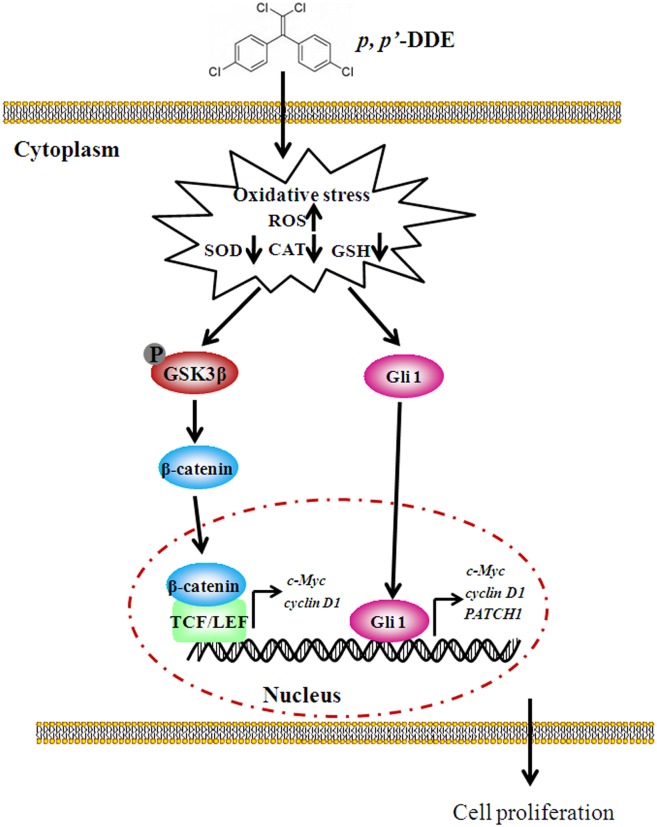
Proposed diagram of p,p′-DDE-induced colorectal adenocarcinoma cell proliferation.At low concentrations, p,p′-DDE promotes colorectal adenocarcinoma cell proliferation through c-Myc and cyclin D1 overexpression resulted from the stimulation of Wnt/β-catenin and Hedgehog/Gli1 signalings, which were mediated by oxidative stress.